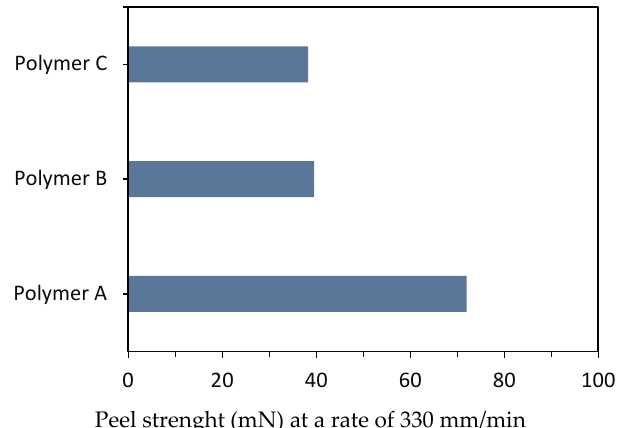
Figure 5. Peel strength comparison between hyaluronic acid